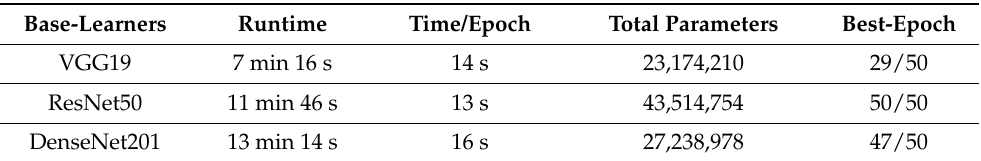
Table 6. Description of the Runtime, Time by epoch, Total parameters, and Best-epoch of the Base- Learners for the COVID-CT dataset